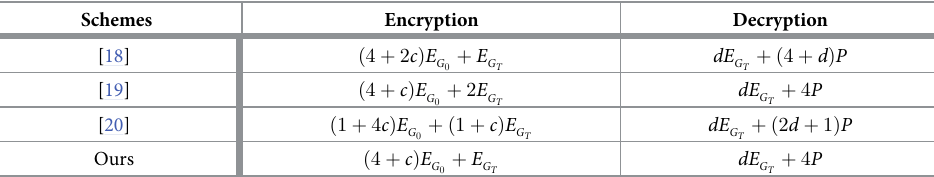
Table 4. Comparison of computation cost.